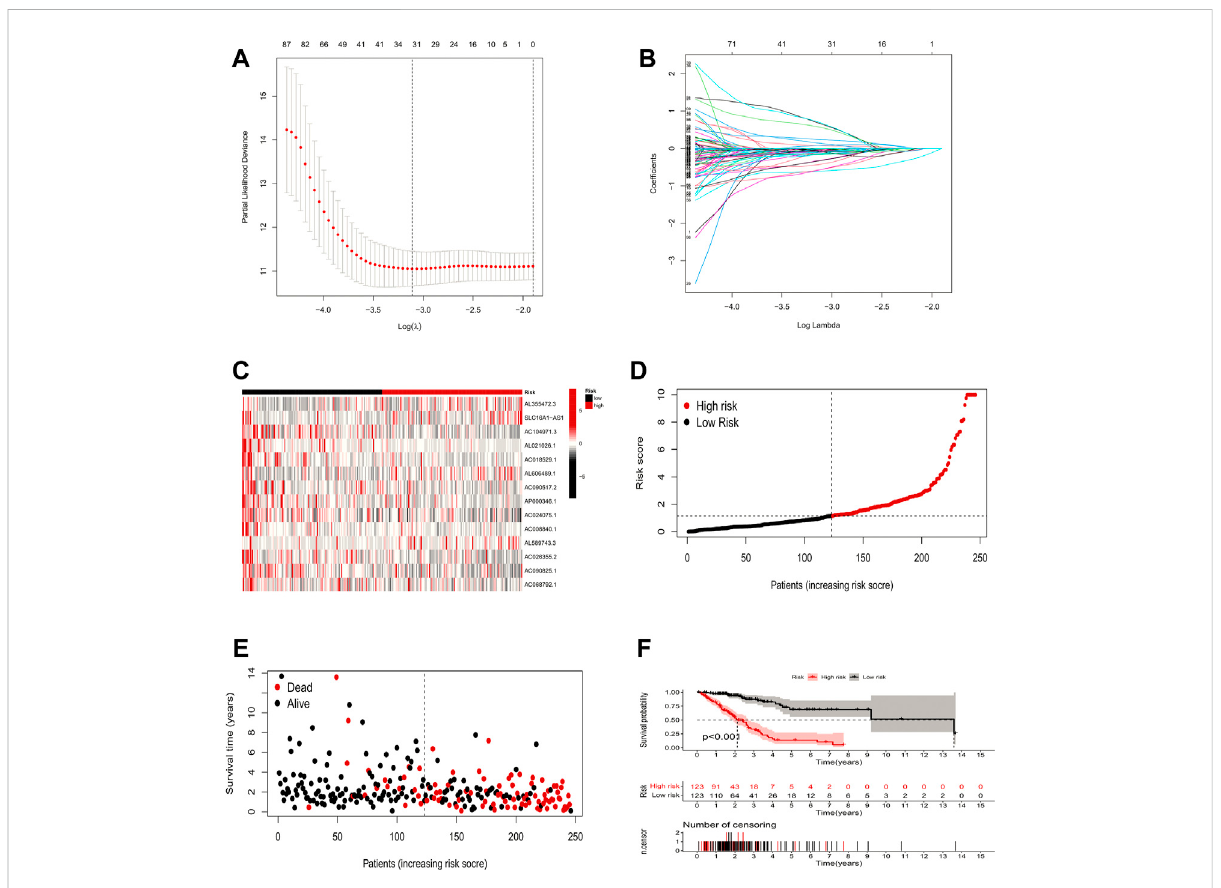
FIGURE 3 Risk model construction and validation. (A,B) Result of LASSO regression analysis. (C) Heatmap to show the expression of 14 lncRNAs between high- and low-risk groups in the training set. (D) Expression differences of 14 ICP-related lncRNAs in different risk groups in the training set. (E) Distribution of sample risk score and different patterns of survival status/time between the high-risk and low-risk groups in the training set. (F) Kaplan-Meier curve of high-risk and low-risk patients in the training